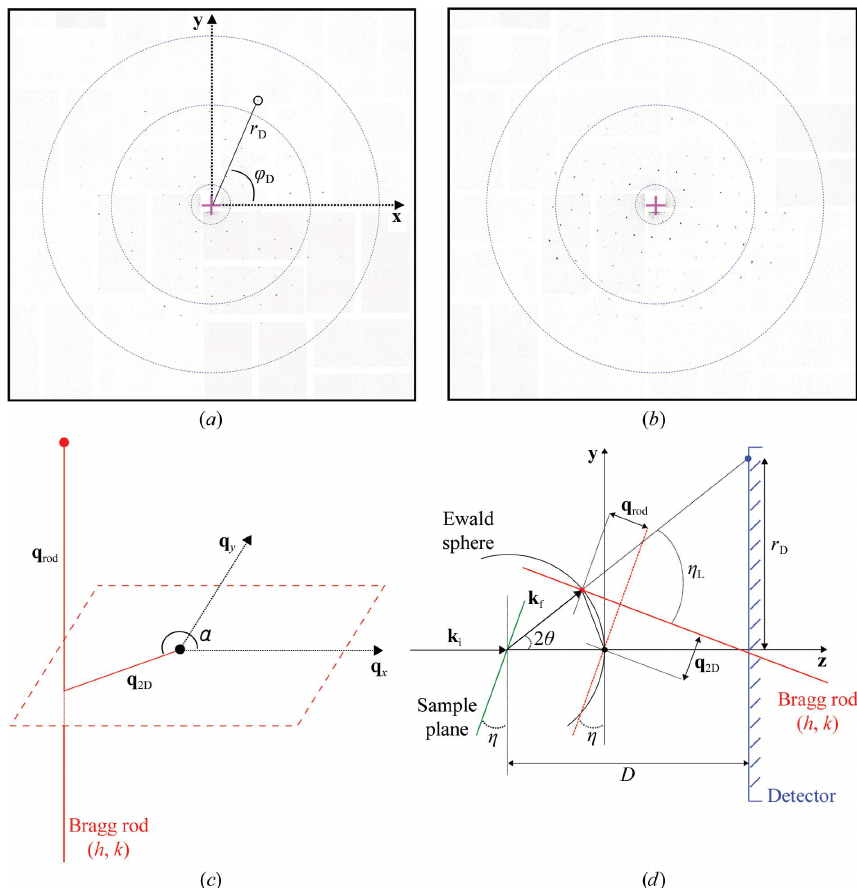
Figure 2 Diffraction from two-dimensional crystals. ( a , b ) Example diffraction images at 5 (cid:2) and 20 (cid:2) tilt angle, respectively. The circles are drawn at 50, 10 and 6 A ˚ resolution. In ( a ), the detector-plane position in polar coordinates ( r D , ’ D ) of a peak is superimposed. ( c ) Three-dimensional reciprocal space with a ^ qq Bragg rod h a * + k b * + q represented as a thick red line. ( d ) Ewald sphere construction for the rod rod diffraction process. The incoming and diffracted wavevectors are labeled k i and k f , respectively. The diffracted beam is generated by the red dot on the Bragg rod. The diffraction angle of the Bragg peak on the detector (blue dot) has scattering angle 2 (cid:5) . The sample plane with tilt angle (cid:2) is represented in